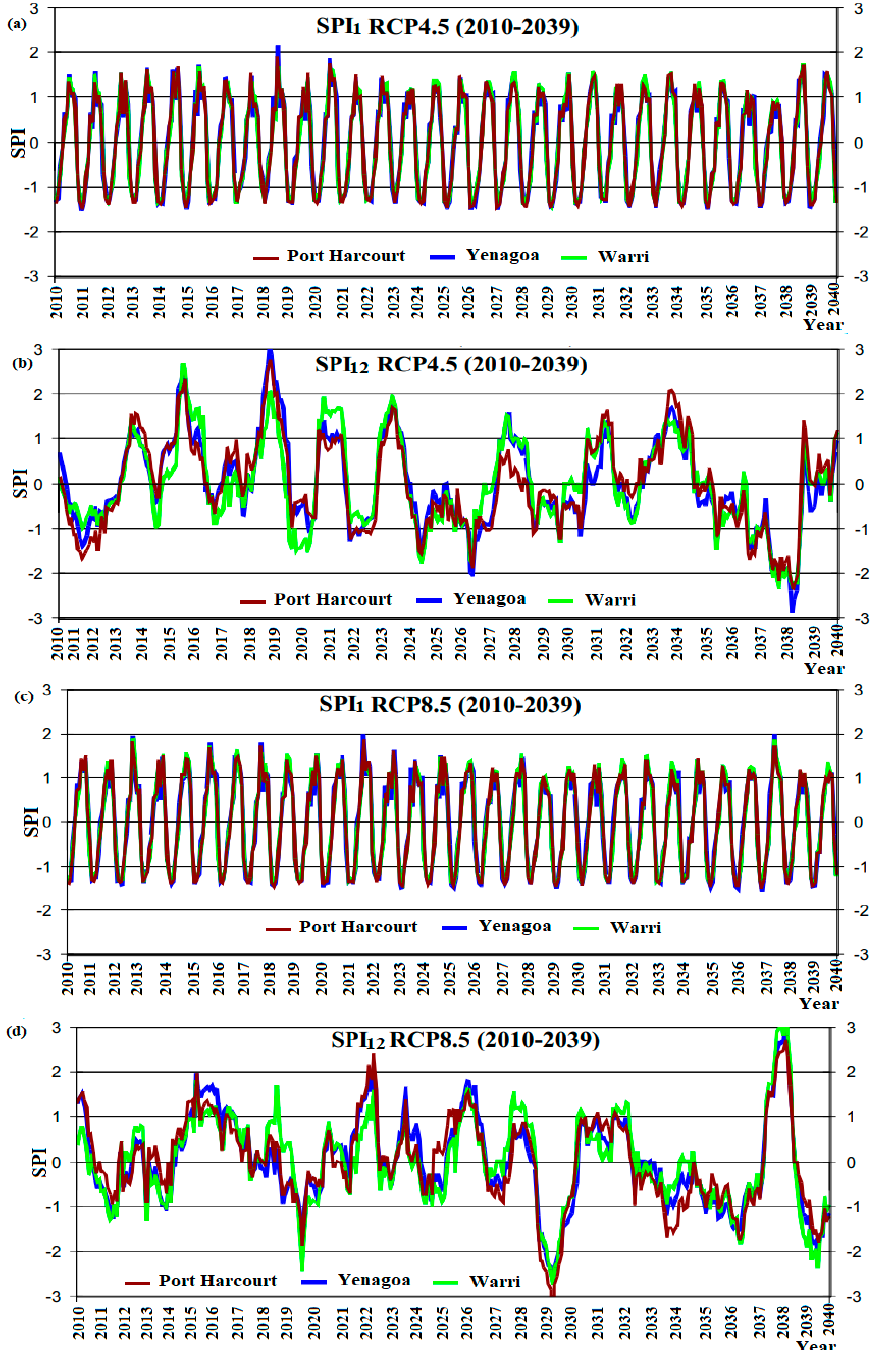
Figure 5. Computed ( a ) 1-month RCP4.5 SPI, ( b ) 12-month RCP4.5 SPI, ( c ) 1-month RCP8.5 SPI, and ( d ) 12-month RCP8.5 SPI for the projected periods from 2010 to 2039 across the study locations.